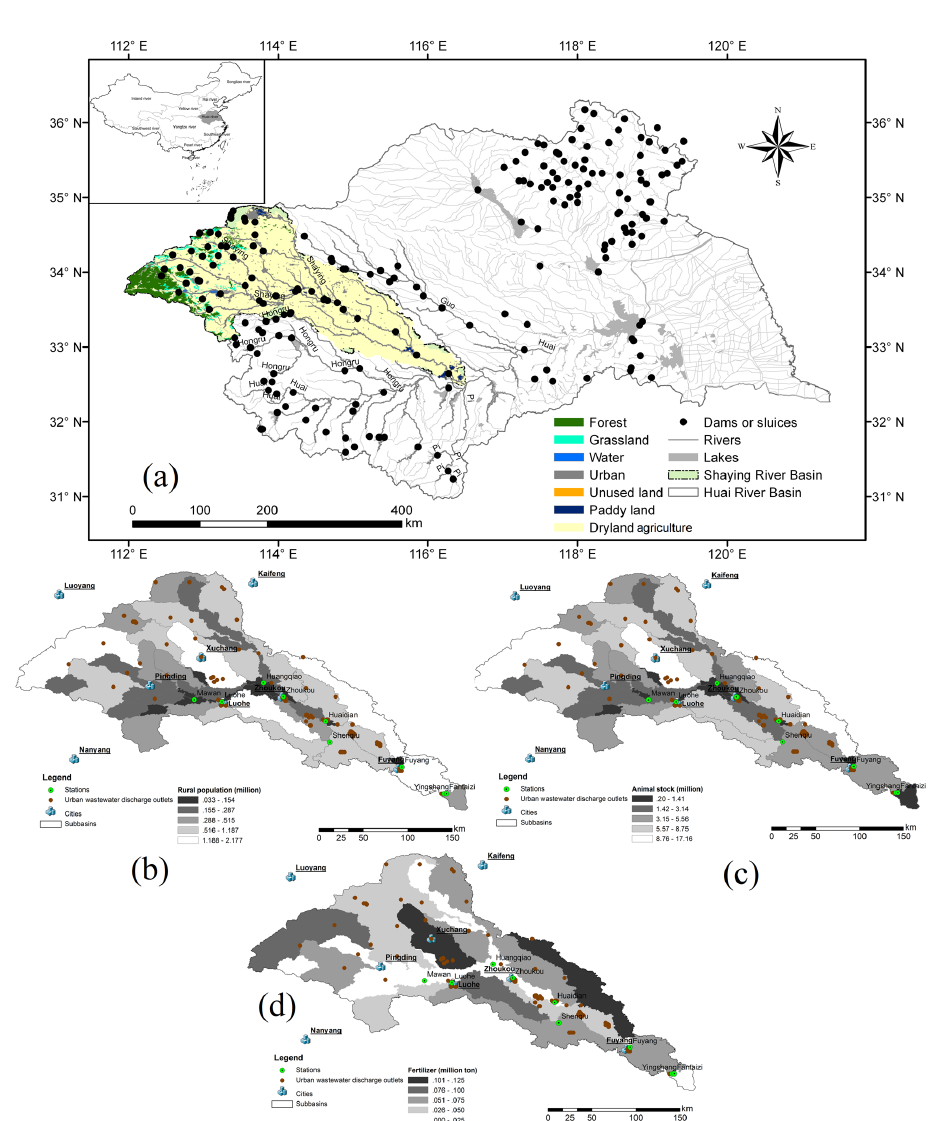
Figure 6. The location of the study area (a) and the digital delineation of the sub-basin, point source pollutant outlets, rural population (b) , animal stock (c) and fertilization (d)